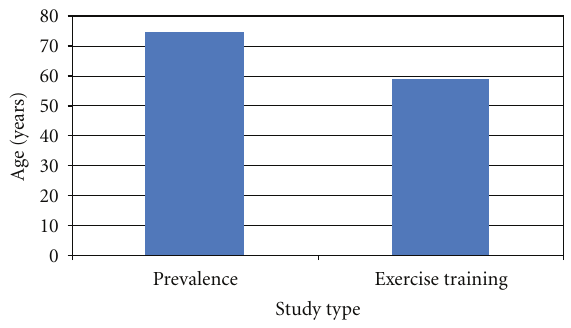
Figure 1: Age comparison of heart failure patients in both preva- lence and exercise studies.